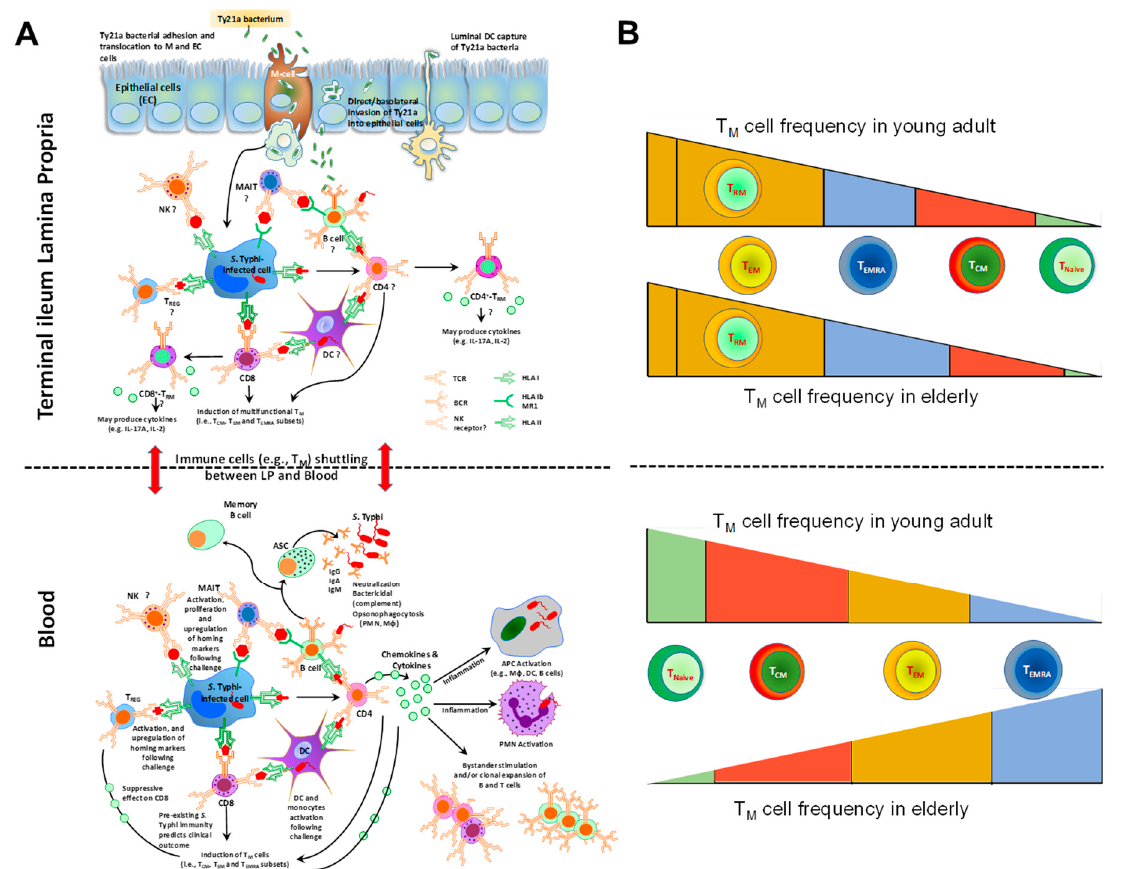
Figure 2. Overview of the Immunity to S . Typhi in Peripheral Blood and the Gut as well as Age-related Changes in T-cell Subsets. ( A ) Immunity to S . Typhi is extremely complex and the diagram summarizes our current knowledge and differences between mucosal and systemic responses to this microorganism. Multiple antigen-presenting cells (e.g., macrophages, dendritic cells, B cells) and effector cells (e.g., various effector and regulatory T-cell subsets, B cells, NK, and MAIT cells) are involved in the immune response. Red arrow indicates migration of specific cells between systemic and mucosal compartments. APC: antigen-presenting cells. ASC: antibody secreting cells. DC: dendritic cells. CD8: CD8 + T cells. CD4, CD4 + T cells. MAIT: mucosal associated invariant T-cells. M φ : macrophages. NK: natural killer cells. PMN: polymorphonuclear neutrophil. T M : memory T-cells. T CM : central memory T cells. T EM : effector memory T cells. T EMRA : effector memory expressing CD45RA. T reg : regulatory T cells. HLA: human leukocytes antigen. HLA-I: HLA class I. HLA-II: HLA class II. BCR: B-cell receptor. TCR: T-cell receptor. MR1: HLA-I non-classical (b) molecule MR1. Ig: immunoglobu-